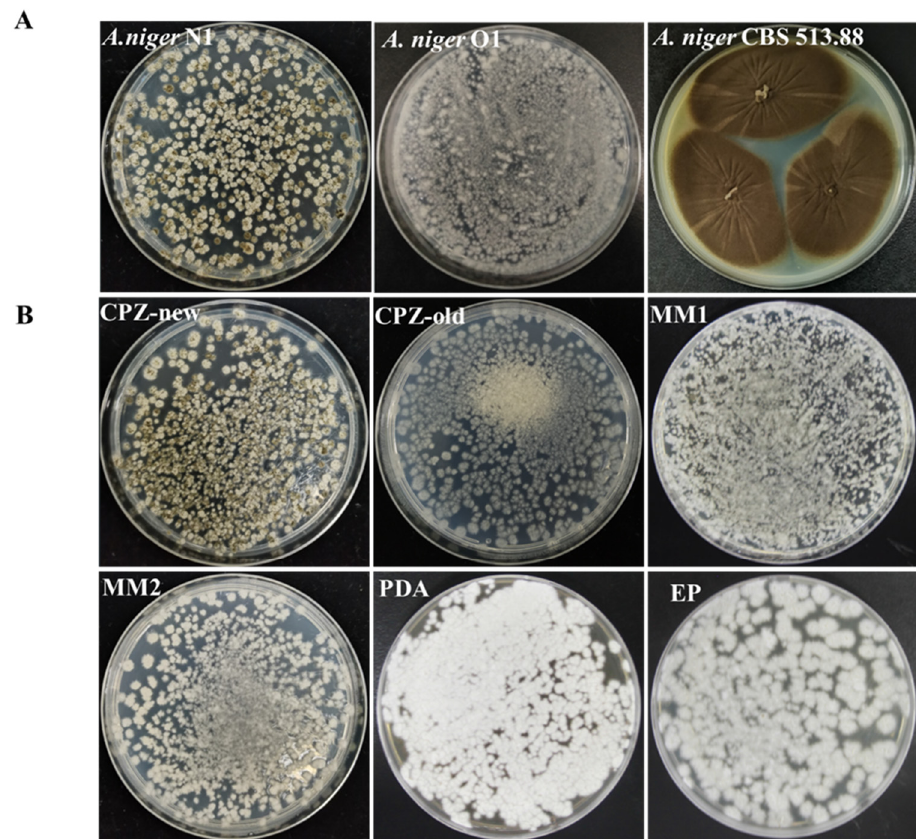
Figure 1. Growth phenotypes of A. niger N1, A. niger O1, and A. niger CBS513.88. ( A ) Conidiation of A. niger N1 after 7-day culture on CPZ-new medium in 9 cm Petri dishes (left image), aconidial A. niger O1 generated on CPZ-old medium for 7 days in 9 cm Petri dishes (middle image), and conidiation of A. niger CBS513.88 after 7-day culture on PDA medium in 9 cm Petri dishes (right image). ( B ) Conidiation of A. niger N1 after 7-day culture on CPZ-new medium in 9 cm Petri dishes (left image) and mycelia of A. niger N1 after 7 days of culture on several commonly used media (CPZ-new, CPZ-old, MM1, MM2, PDA, and EP).